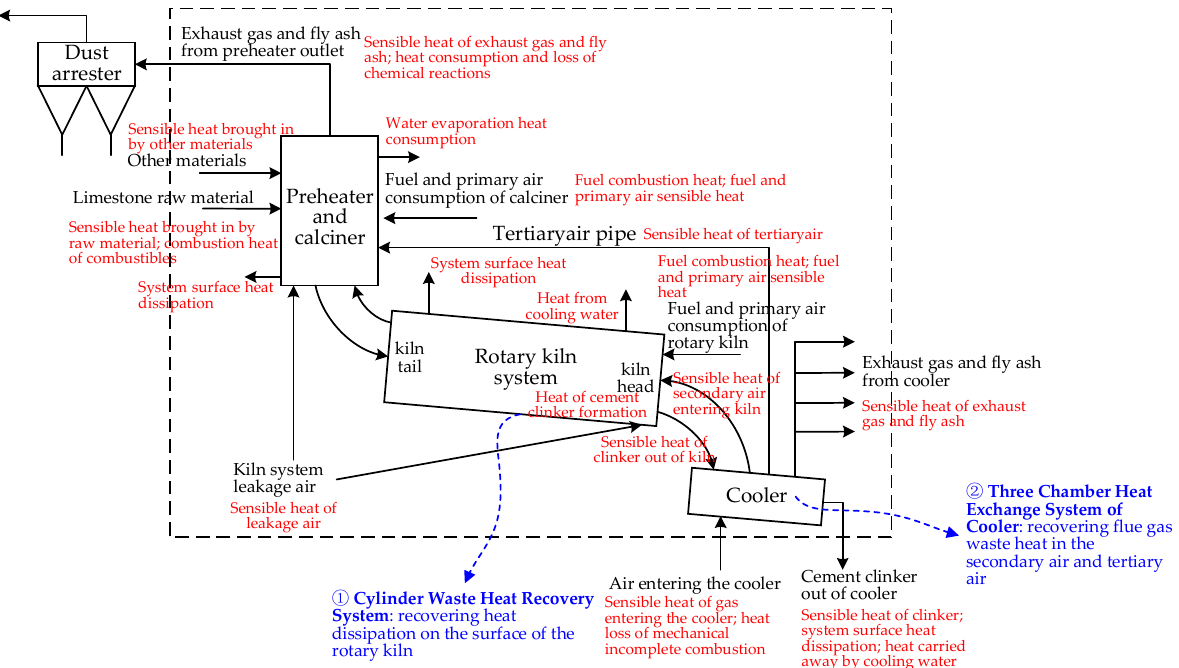
Figure 2. Internal Material Balance and Heat Balance of Cement Rotary Kiln System.